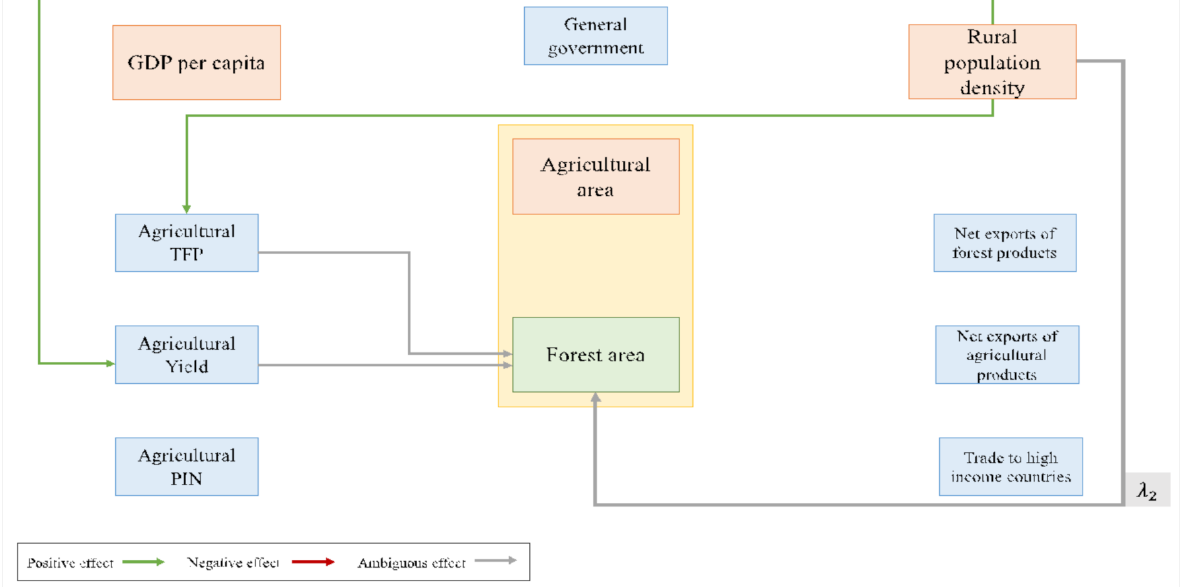
Figure A3. Estimating indirect effects of “RurPopDensity”